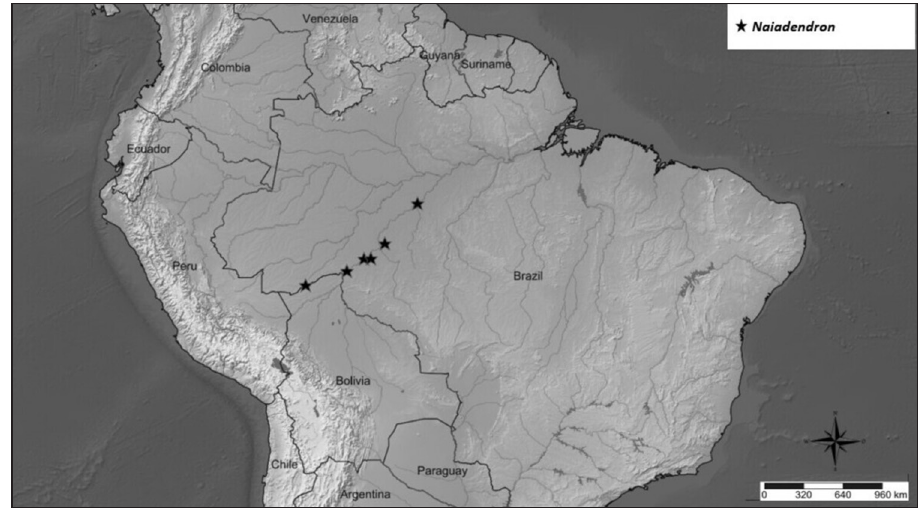
Figure 9. Distribution of Naiadendron duckeanum